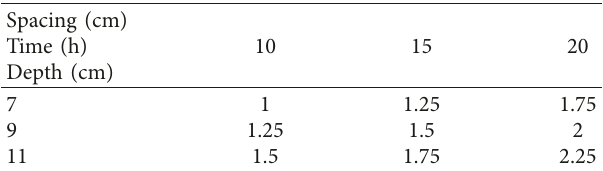
Figure 13: Temperature of the HSMP surface at the outlet section with different pipe spacing: (a) pipe embedded depth of 7cm; (b) pipe embedded depth of 11 cm. Table 3: The numbers of hours for HSMP surface temperature below 0 °